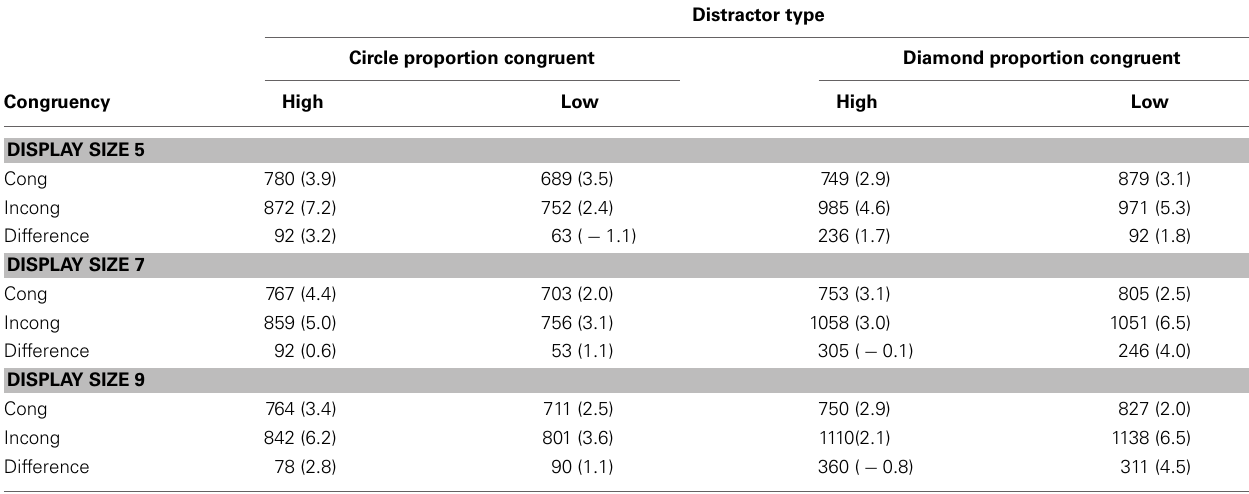
FIGURE 5 | ExamplesoftheeighttrialtypespresentinExperiment3when the target was a square (the triangle target condition is not shown). The fourtrialtypesontheleftsideareun-cuedtrials,wheretheparticipantwasonly instructed to search for the unique shape in the display. The four trial types on Table 4A | Mean response times and error percentages (in parentheses) for the informative cued trials, collapsed across target (triangle/square) and block, in Experiment